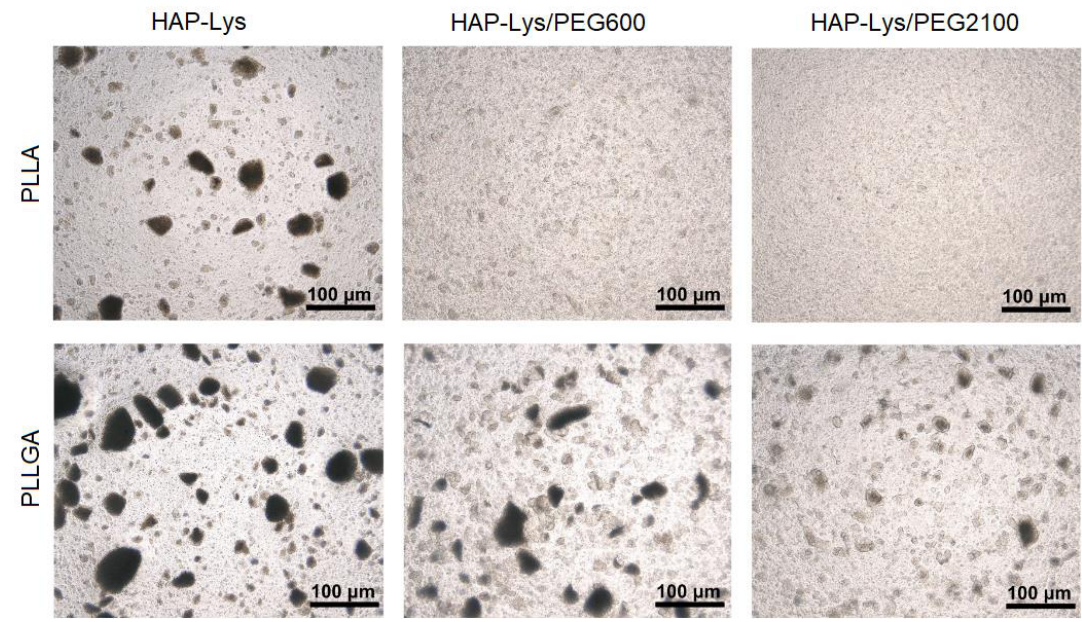
Figure 4. Optical images of composite films.